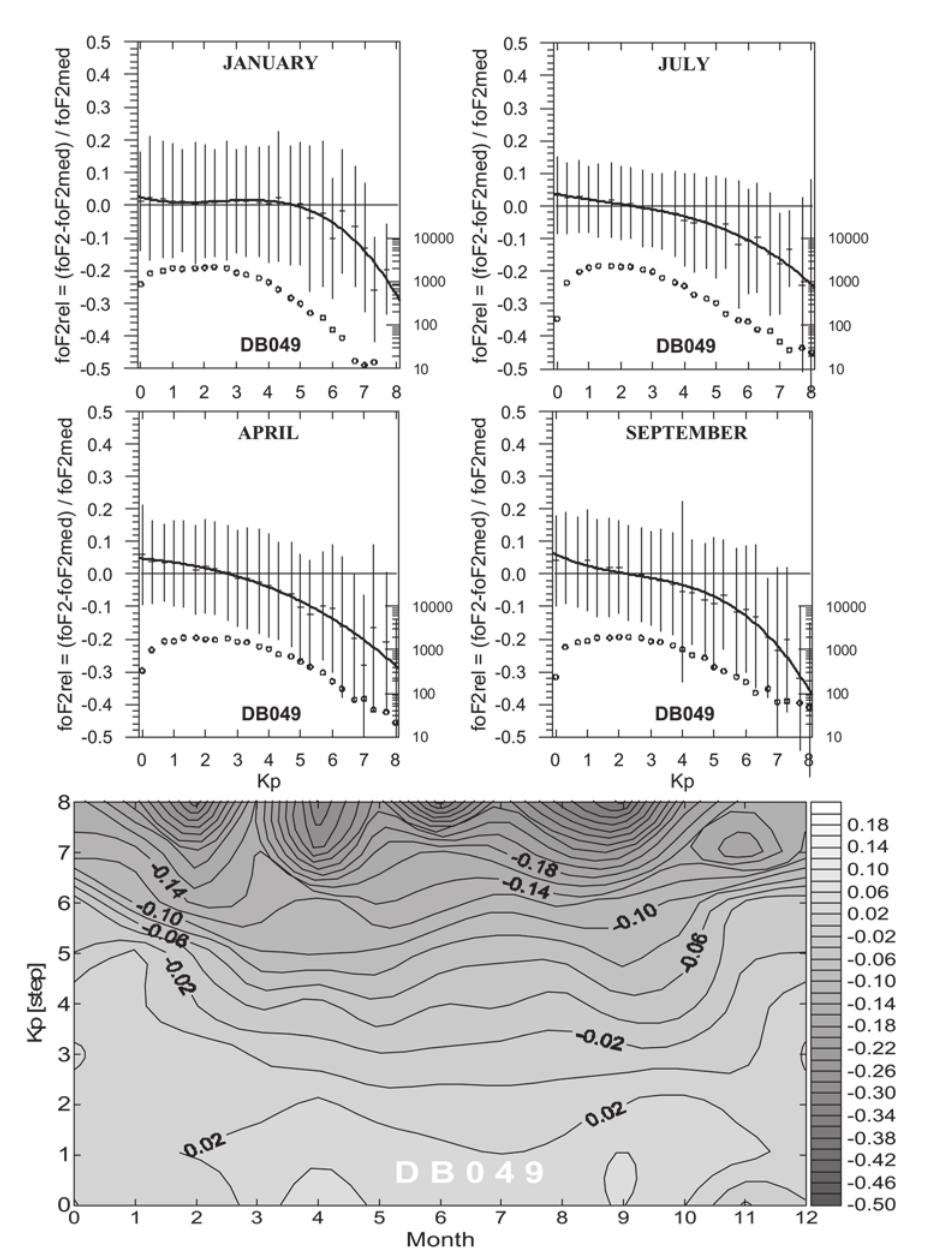
Fig. 5. The f F F relative deviations ( f ) response to geomagnetic activity for the site of ionosonde station 0 2 0 2rel DB049 (4.6 ° E, 50.1 ° N) based on data from the 1957-1989 period. The average values of f approximated by 3 − rd degree polynomials (solid lines). The vertical bars represent the standard deviations (doubled), and circles represent the data number (scaled on the right-hand